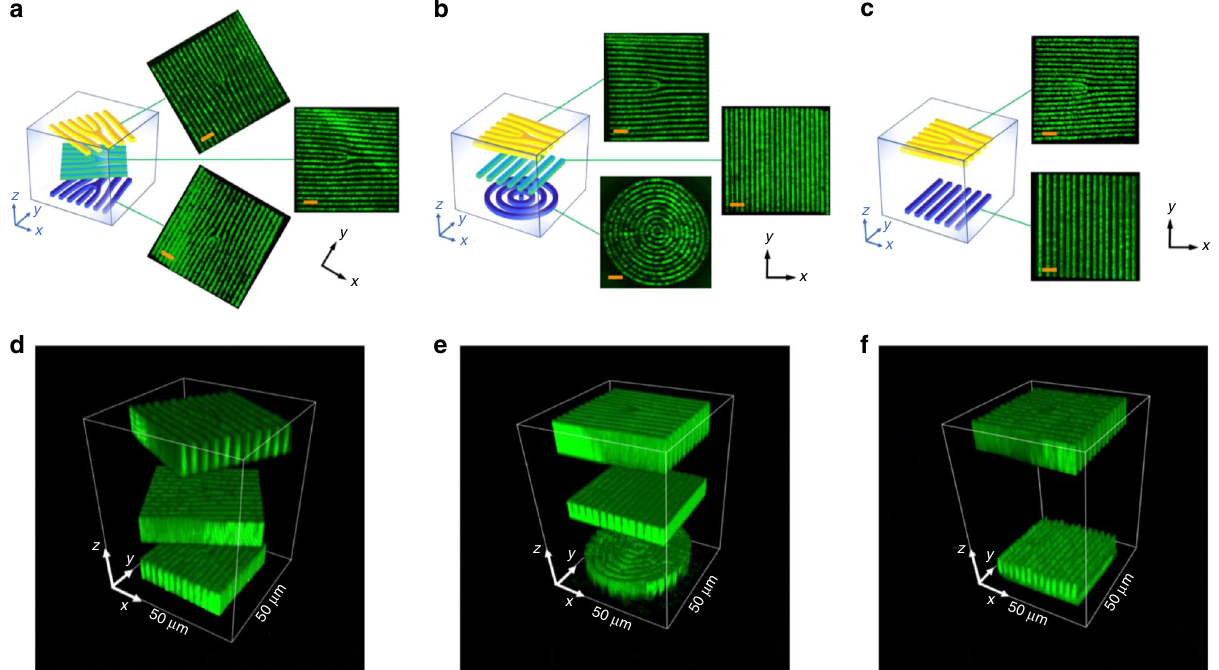
Fig. 2 Schematic representation of multilayer spatial modulation of χ (2) nonlinearity in 3D nonlinear photonic crystals. a Three-layer fork structures with a rotation of 60° from each other. b Fork, linear grating and circular grating. c Two-layer fork and linear grating. d – f The 3-D visualization of these actual structures obtained by the nonlinear Č erenkov microscopy 35 . In these fi gures the χ (2) grating period is Λ = 3 μ m, and the topological charge of the fork structure is l c = 2. The three-layer domain structures are located about 23, 69, and 115 μ m below the surface of the crystal, respectively in d and e , and the two layers are located about 23 and 345 μ m below the surface in f . The length of the scale bar is 10 µ m in a –